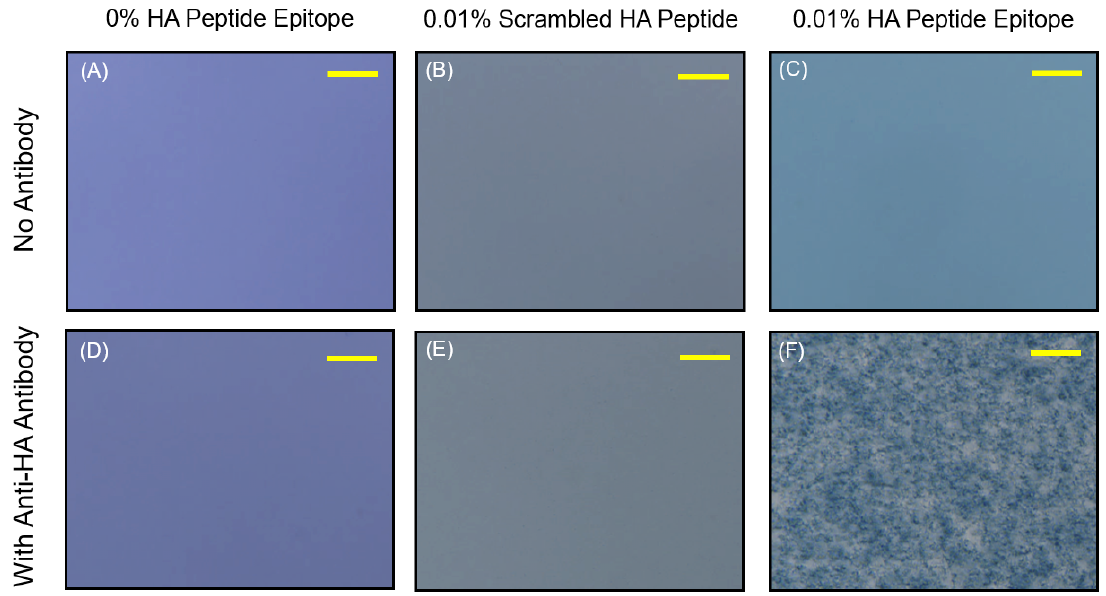
Figure 6. Phase contrast microscopy (scale bar = 10 um) images of vesicle samples displaying 0% HA epitope, 0.01% scrambled HA peptide, or 0.01% HA peptide epitope ( A – C ) without the addition of antibody as compared to those samples ( D – F ) with the addition of soluble anti-HA antibody (33 ng/uL), revealing aggregation specifically for the case of those vesicles possessing 0.01% HA peptide epitope.